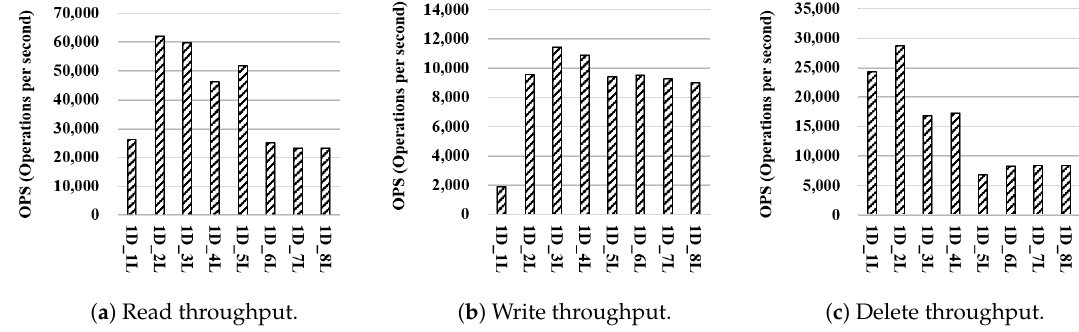
Figure 6. Performance of WR-Store as WR L is varied. ( a ) Read throughput; ( b ) Write throughput; ( c ) Delete throughput.